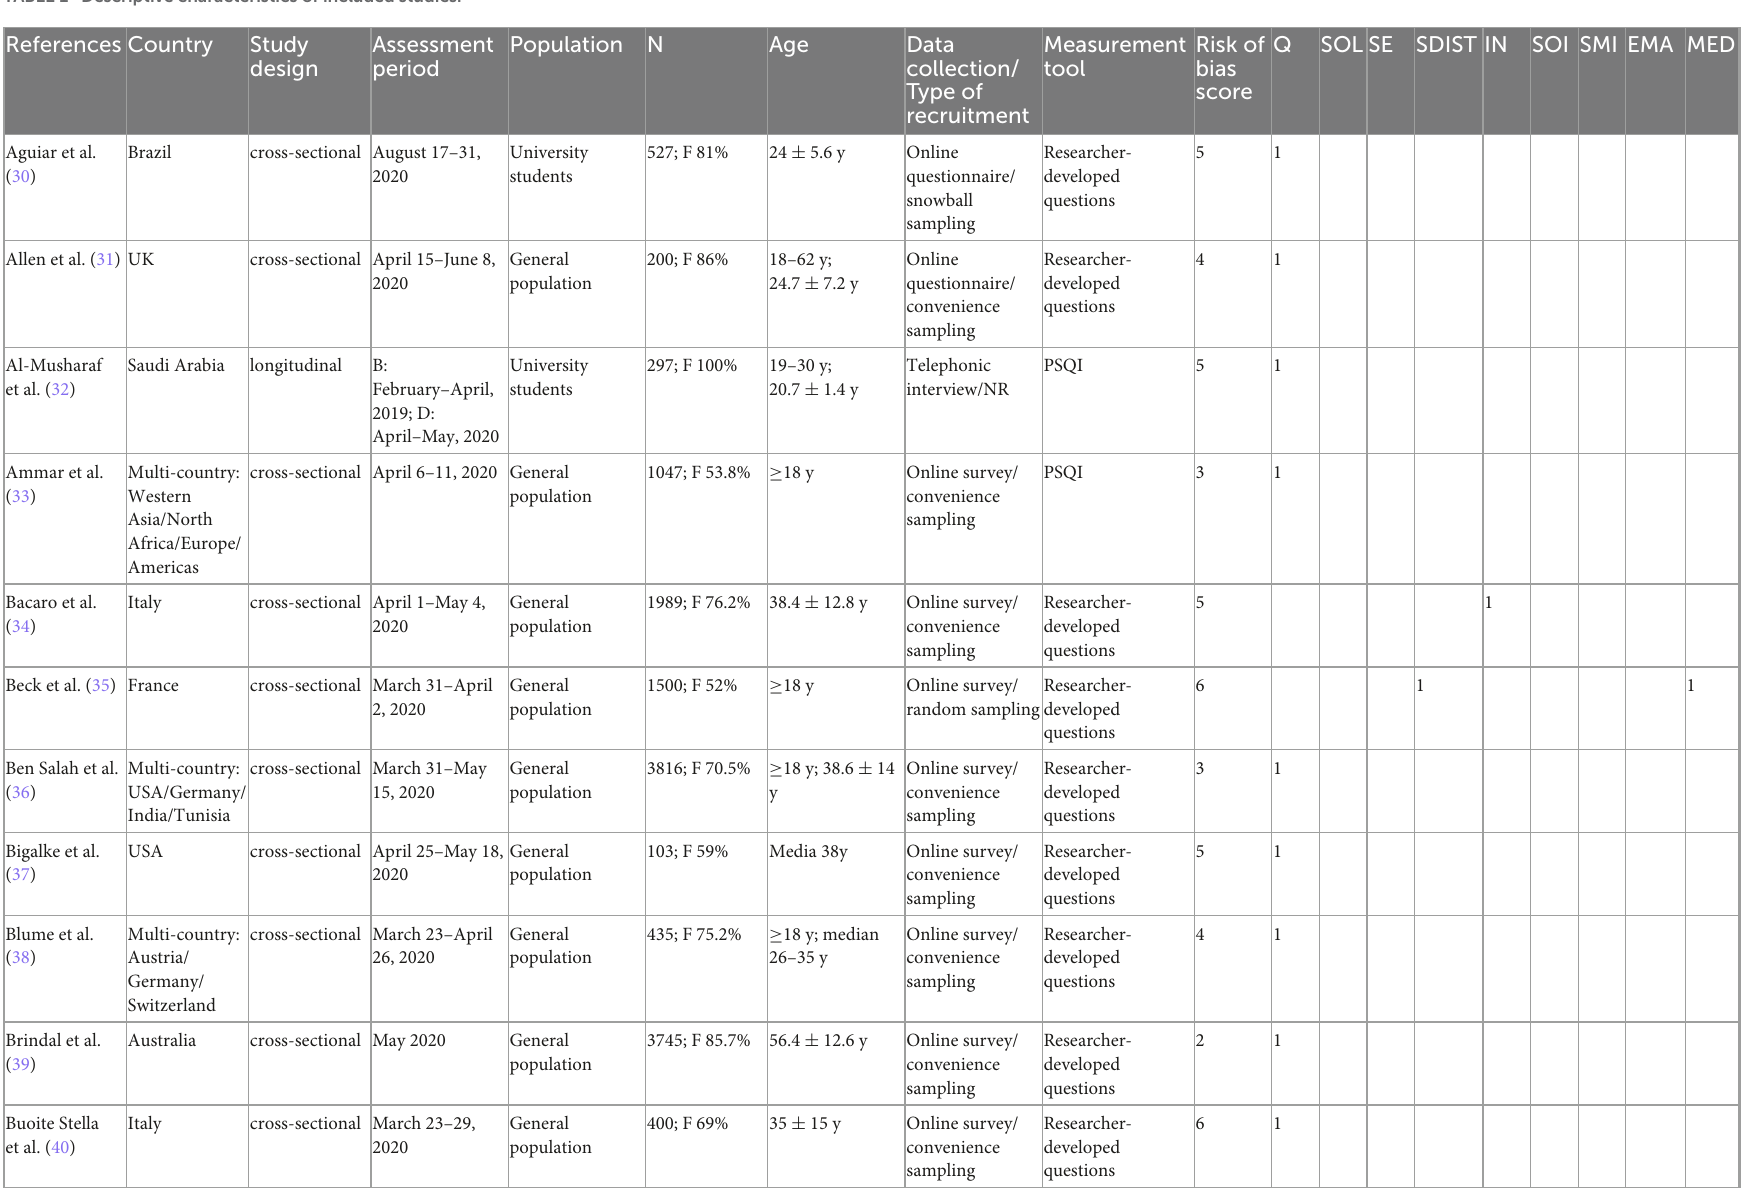
TABLE 1 Descriptive characteristics of included